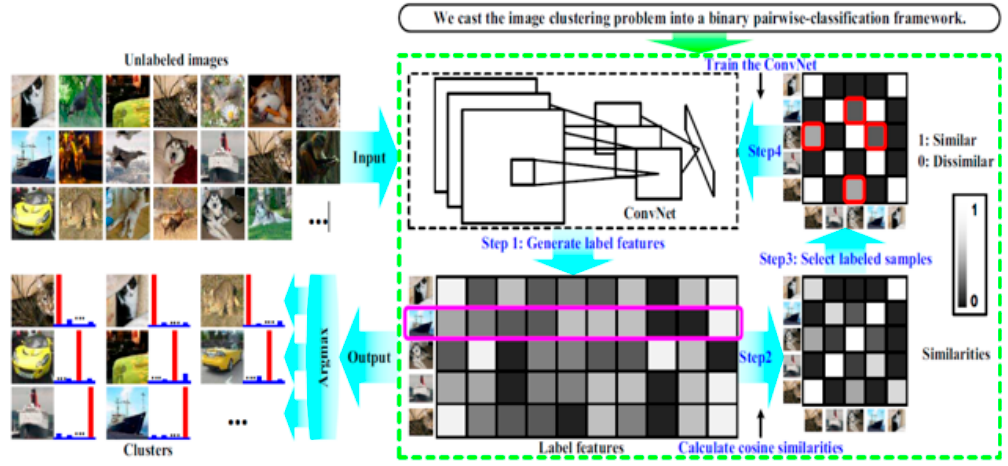
Figure 5. Flowchart of the deep adaptive clustering (DAC) algorithm [36].